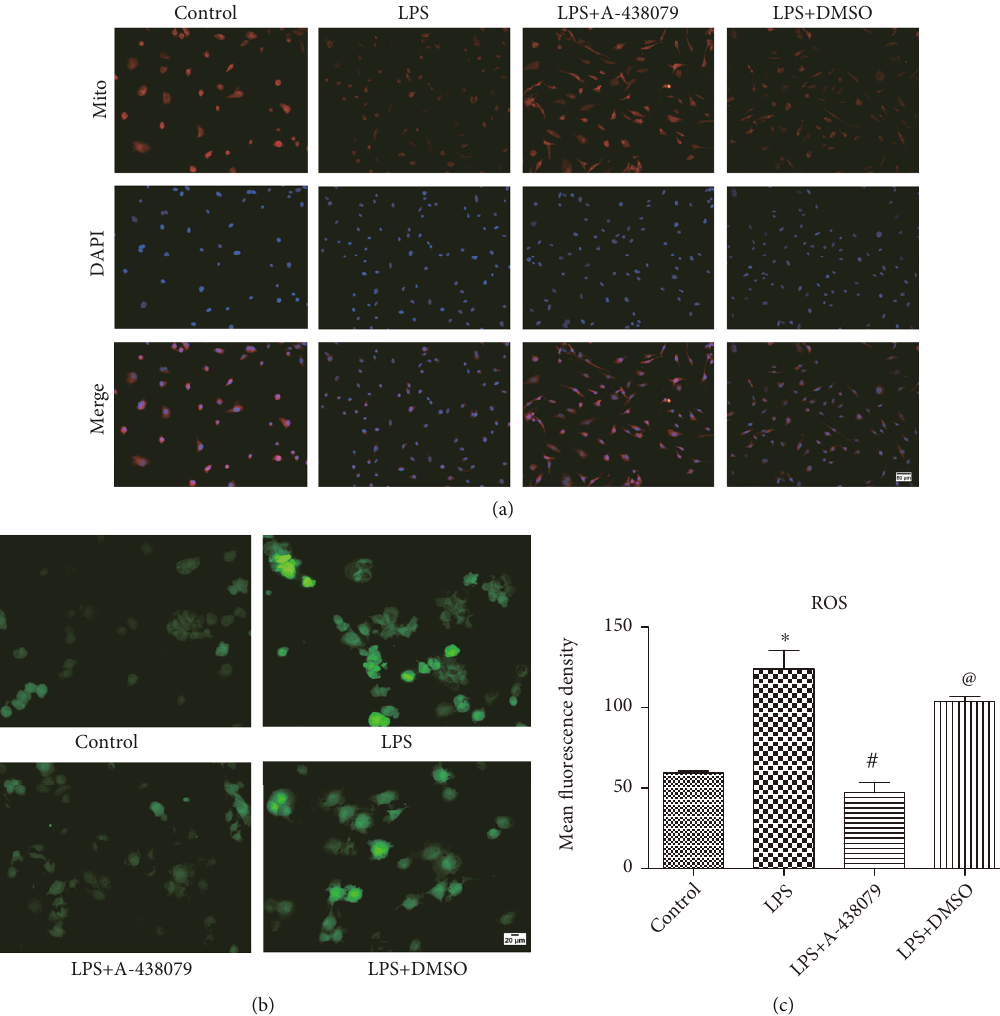
Figure 3: E ff ects of LPS or A-438079 on ROS production and mitochondrial membrane potential in HBMECs in vitro. (a) The adherent HBMECs in the LPS + A − 438079 group were treated with A-438079 for an hour and then treated with LPS for 12 hours. The same cells in the LPS + DMSO group were treated with DMSO for an hour and then treated with LPS for 12 hours. The LPS group was treated with LPS one hour after the addition of the same amount of normal saline for 12 hours. Mito-tracker Red CMXROS was used to evaluate the mitochondrial membrane potential in each group, and the intensity of red fl uorescence signal in each group indicated the change of mitochondrial membrane potential. Scale bars = 50 μ m . (b) A fl uorescence microscope was used to observe the production of ROS in each group. Scale bars = 20 μ m . (c) The fl uorescence signals of di ff erent groups were analyzed using ImageJ. All data are expressed as mean ± SD . ∗ P < 0 : 05 vs. control group, # P < 0 : 05 vs. LPS group, and @ P < 0 : 05 vs. LPS + A − 438079